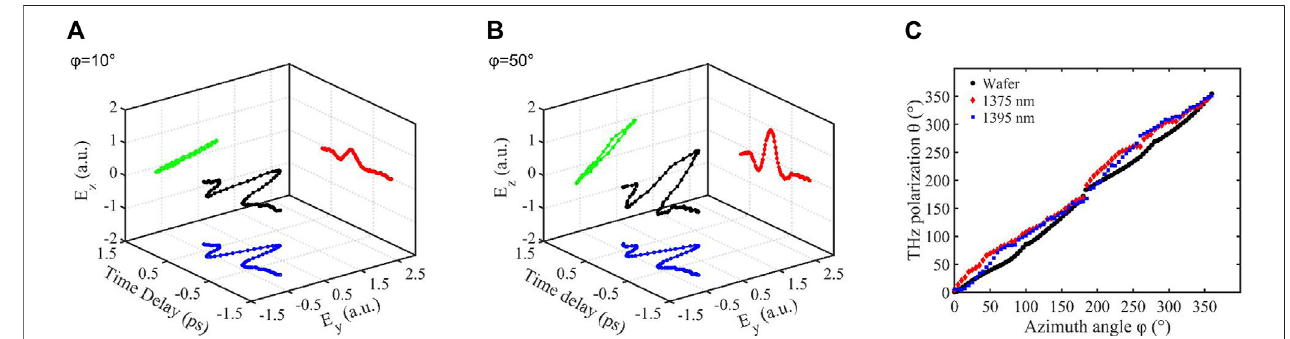
FIGURE5| DependenceofTHzpolarizationontheorientationoftheopticalaxis.3DplotsoftheTHzwavesgeneratedfromtheLiNbO 3 metasurfacewithazimuthal angles φ (cid:1) 10 ° (A) and φ (cid:1) 50 ° (B) excitedintheresonantwavelengthof1,395 nm E THz z (red)and E THz y (blue)componentscomprisedTHzwaves(black).Thepolarization plane ofTHz wavesisprojectedonto they-z coordinateplane (green) withthe polarizationangle θ departing fromthe y -axis. (C) Dependence ofthepolarizationangle of THz waves on the azimuthal angle of the optical axis of the LiNbO 3 wafer (black) and metasurface excited with 1,375 nm (red) and 1,395 nm (blue).